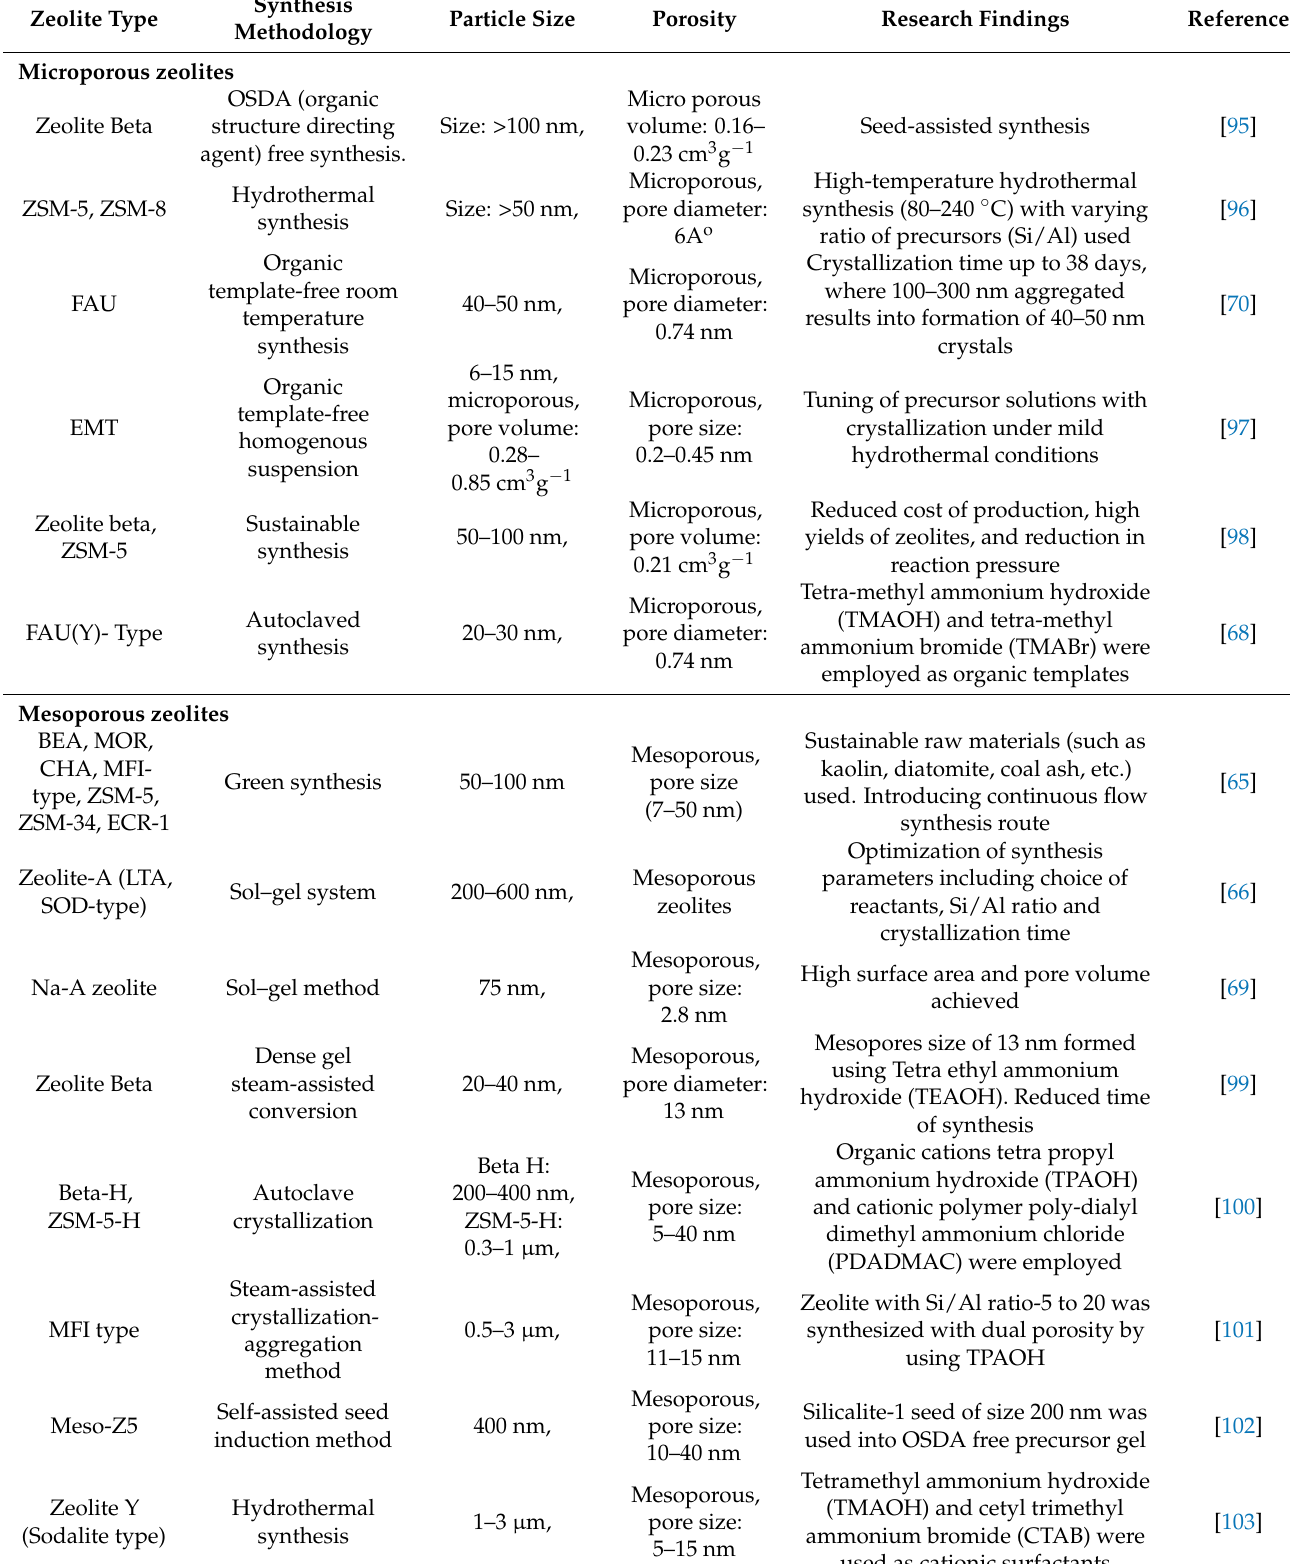
Table 1. Synthesis methodologies adopted for micro-, meso- and macroporous zeolites and their